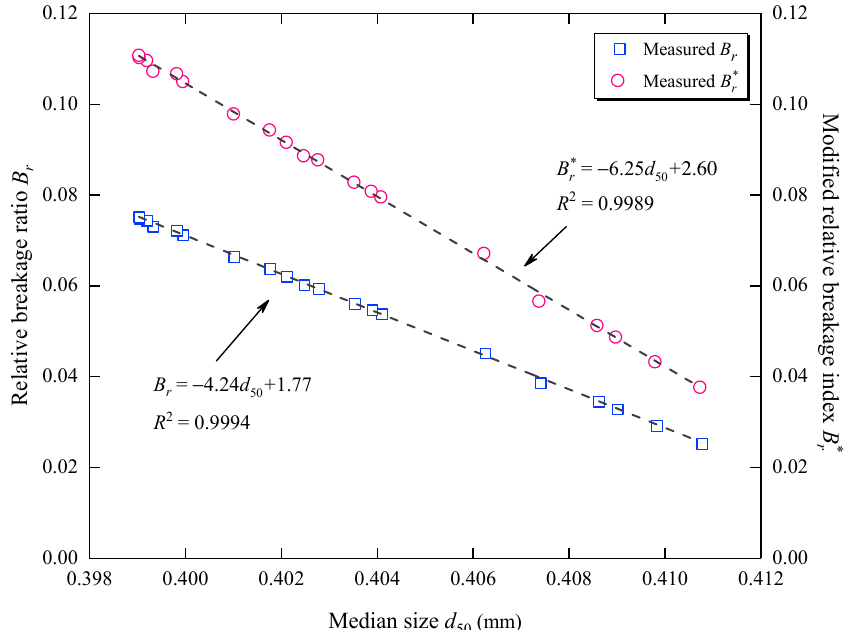
Figure 21. Relationship between relative breakage ratio, modified relative breakage index, and median particle size of coral sand.